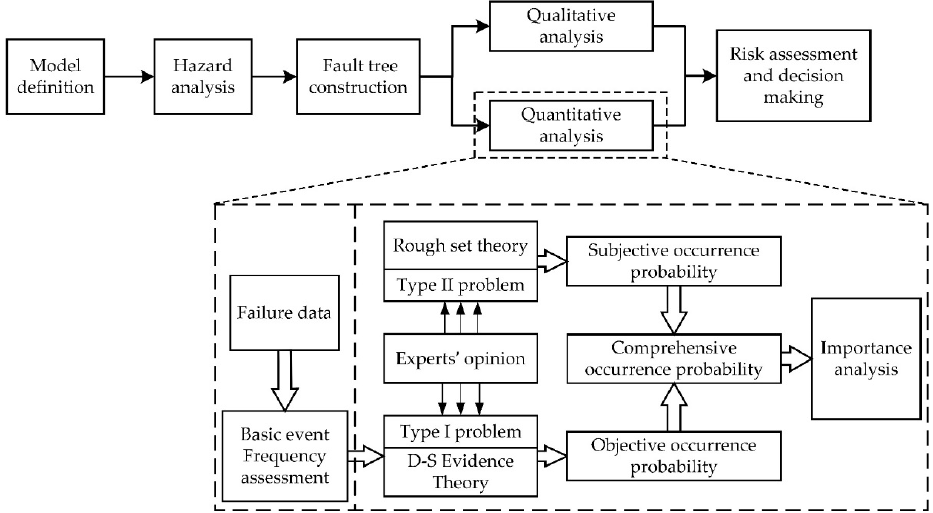
Figure 1. The framework of FTA for the hydraulic system of HCMT.